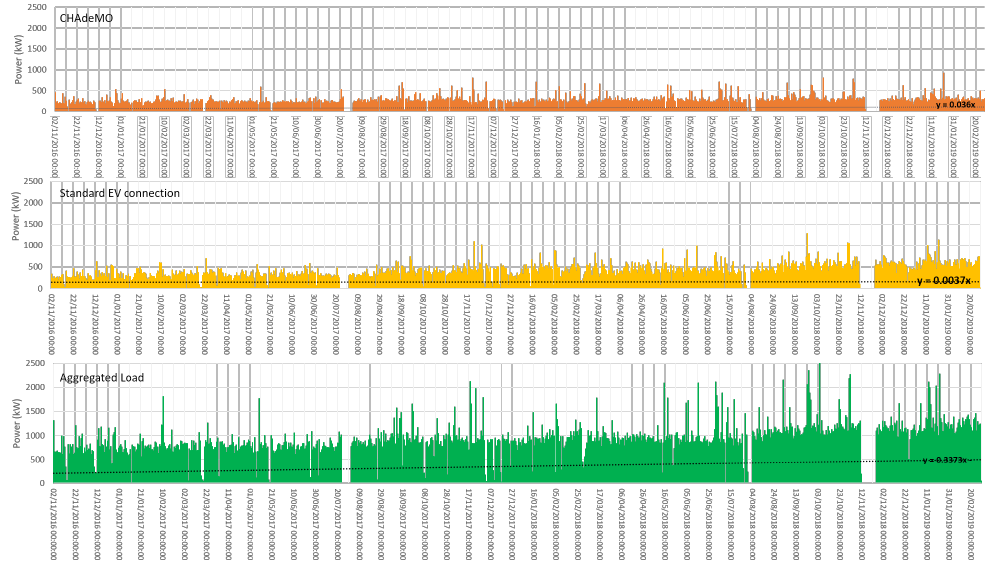
Figure 10. Irish public charging infrastructure power consumption